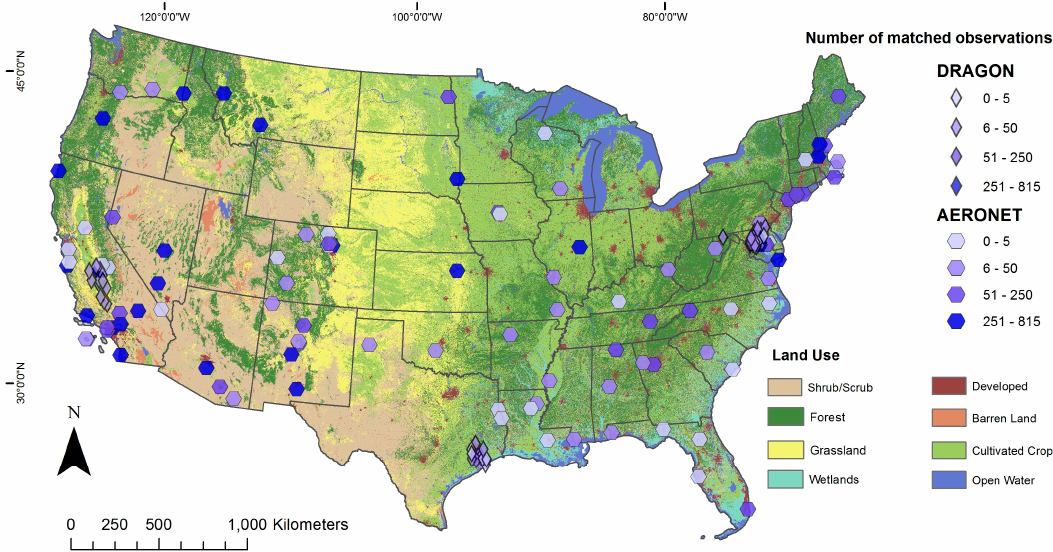
Figure 1. Spatial distribution of AERONET (hexagons) and DRAGON (diamonds) sites over the study period from 1 January 2004 to 31 December 2013. The color of the symbols represents the number of collocations at each site.